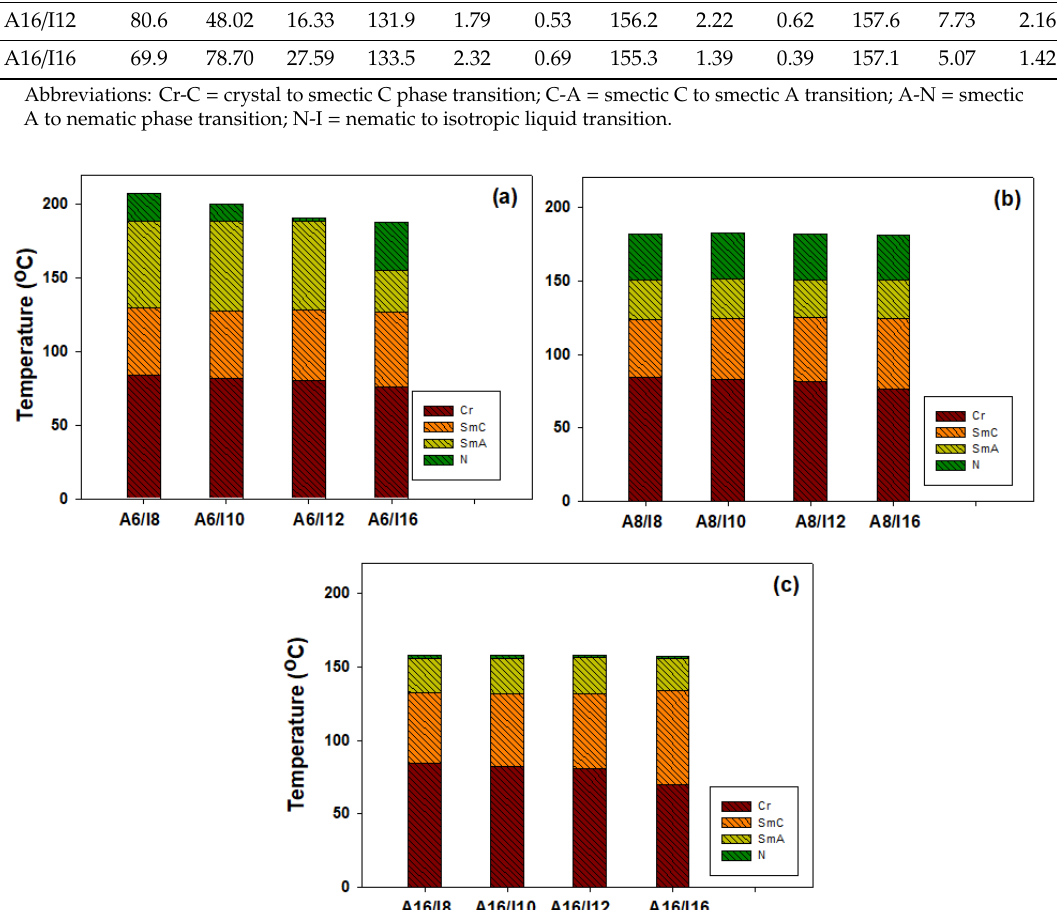
Figure 3. Polarizing optical microscopy (POM) textures upon heating of SMHBC A16 / I10 ( a ) SmC phase at 120.0 °C; ( b ) SmA phase at 143.0 °C ; and ( c ) nematic phase at 157.0 °C.